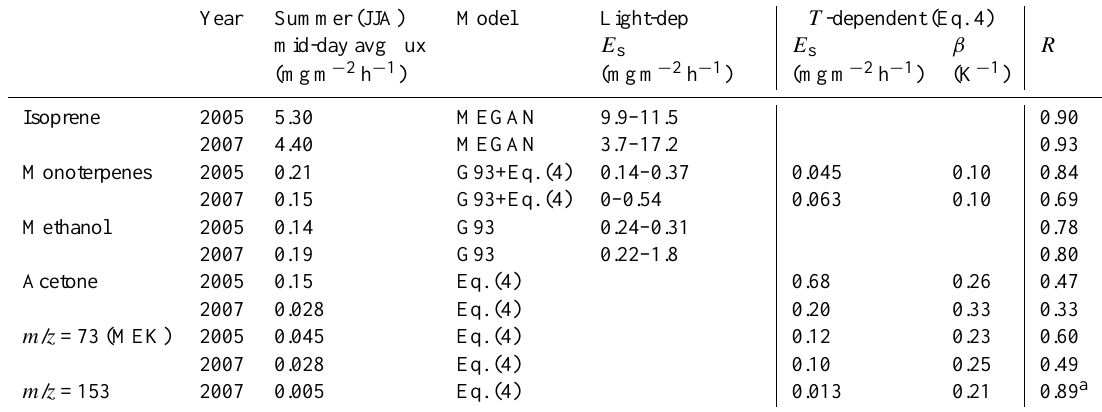
Table 3. Summer mid-day average fluxes and standard emission rates of each species. Standard emission rates are obtained using the model and other fit parameters listed below.